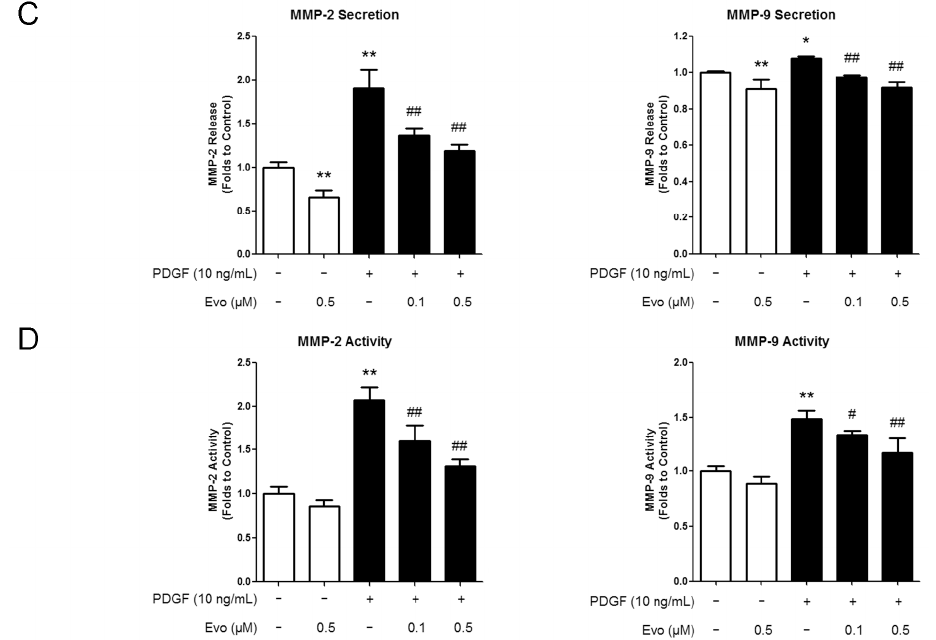
Figure 2. Evodiamine inhibits the expression of migration-associated regulators. ( A ) VSMCs were pretreated with evodiamine for 6 h and then stimulated with PDGF-BB for another 24 h. Western blot was used to measure the protein expression levels of regulators involved in the VSMC migration, including matrix metalloproteinase (MMP)-2, MMP-9, intercellular adhesion molecule-1 (ICAM-1), vascular cell adhesion molecule-1 (VCAM-1), and osteopontin (OPN). For both MMP-2 and MMP-9, their latent forms (72 and 92 kDa, respectively) were detected; ( B ) The signal ratio of examined protein to the internal control glyceraldehyde-3-phosphate dehydrogenase (GAPDH) was quantified by densitometric scanning; ( C ) The concentrations of MMP-2 and -9 in the culture medium were detected by Enzyme Linked Immunosorbent Assay (ELISA); ( D ) The activities of MMP-2 and MMP-9 were determined by using their respective Biotrak Activity Assay Systems. Evo, evodiamine. Data are presented as mean values ± SD of three independent experiments. * p < 0.05, ** p < 0.01 compared with the control group; # p < 0.05, ## p < 0.01 compared with the PDGF-BB-stimulated group.